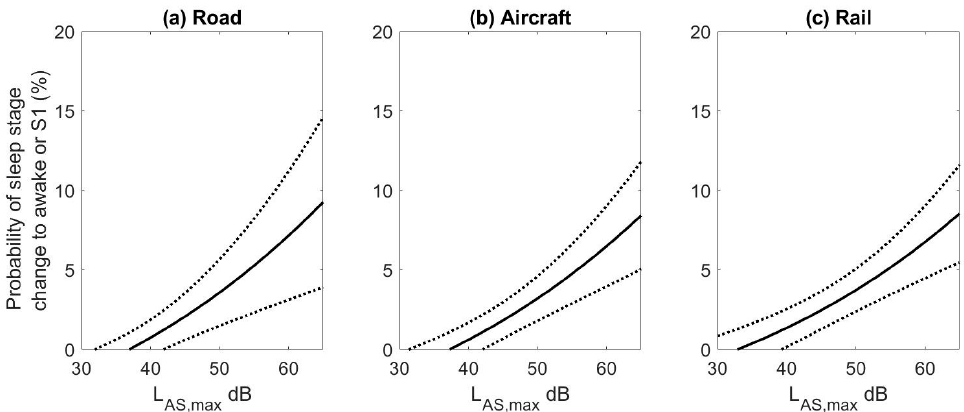
Figure 6. Probability of additional sleep stage changes to awake or S1 in a 90 s time window following noise event onset depending on the maximum indoor sound pressure level (L AS,max ) for ( a ) road (STRAIN and DEUFRAKO, N = 94 subjects); ( b ) aircraft (STRAIN, N = 61); and ( c ) rail noise (DEUFRAKO, N = 33). 95% confidence intervals (dashed lines). Results are for the three unadjusted models.